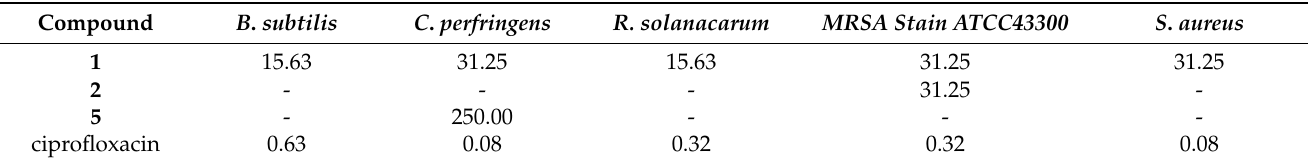
Table 4. Minimum inhibitory concentrations (MIC, µ g/mL) of 1 – 2 and 5 against bacterial test organisms.